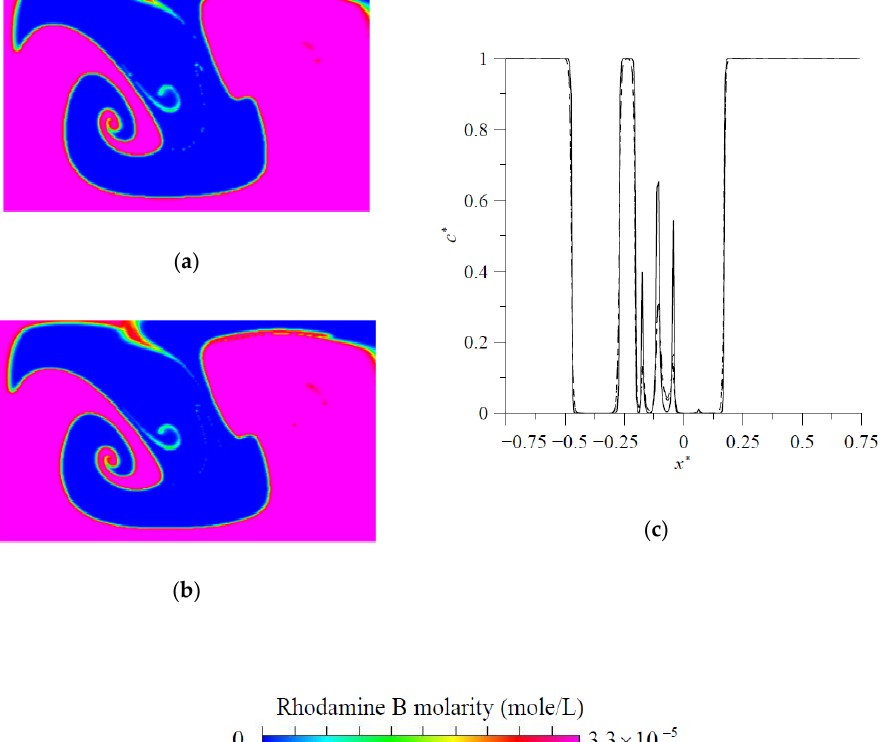
Figure5. Concentrationdistributionsonthecross-sectionat y = 360 µ mobtainedbytheparticletracking methodwithanADM:concentrationdistributionsonthecross-sectionbyusing( a ) N xt × N zt = 360 × 180 particles and ( b ) N xt × N zt = 480 × 240 particles, ( c ) concentration profiles along the middle horizontal on the cross-section at y = 360 µ m by using N xt × N zt = 240 × 120 particles ( − − − −− −−− − − − ─ ; N xt × N zt = 360 × 180 particles ( − − − − ); N xt × N zt = 480 × 240 particles ( −− − −− - −−− − − ).